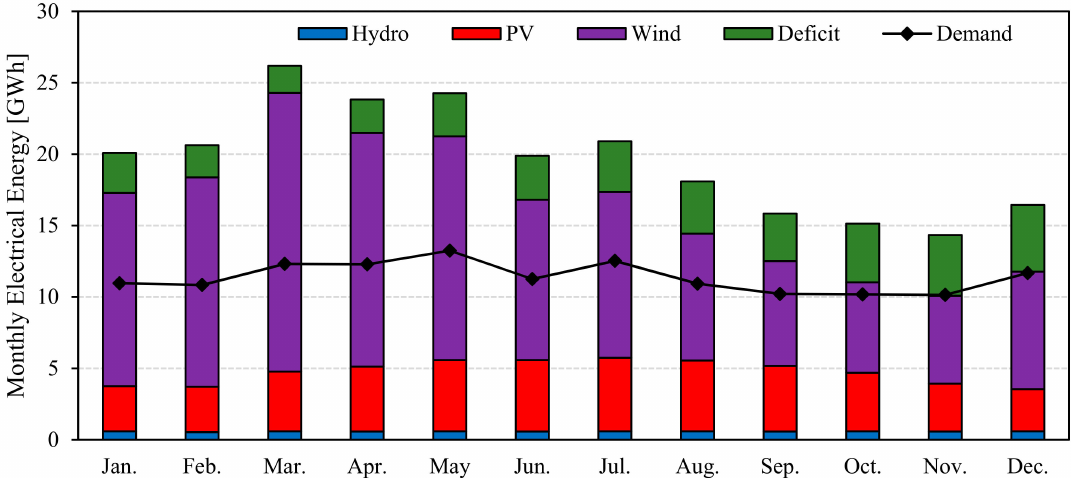
Figure 4. Monthly energy generation by the RES components without